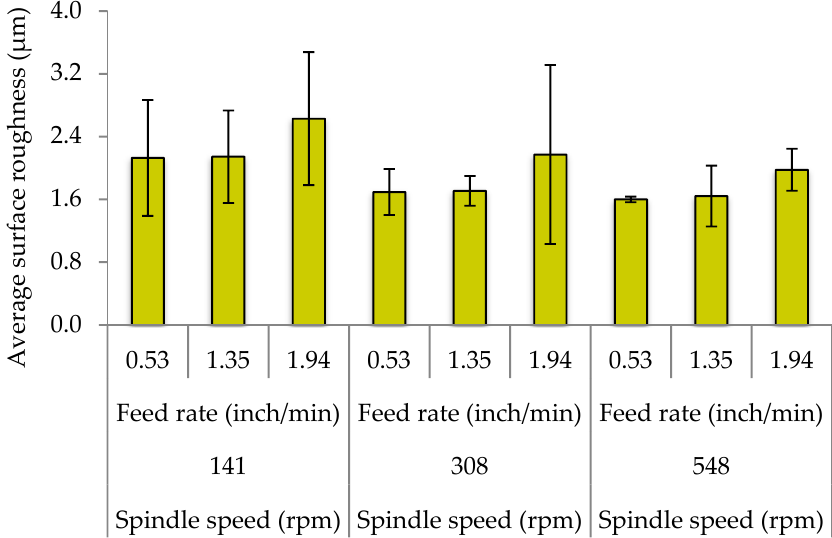
Figure 1. Average surface roughness.